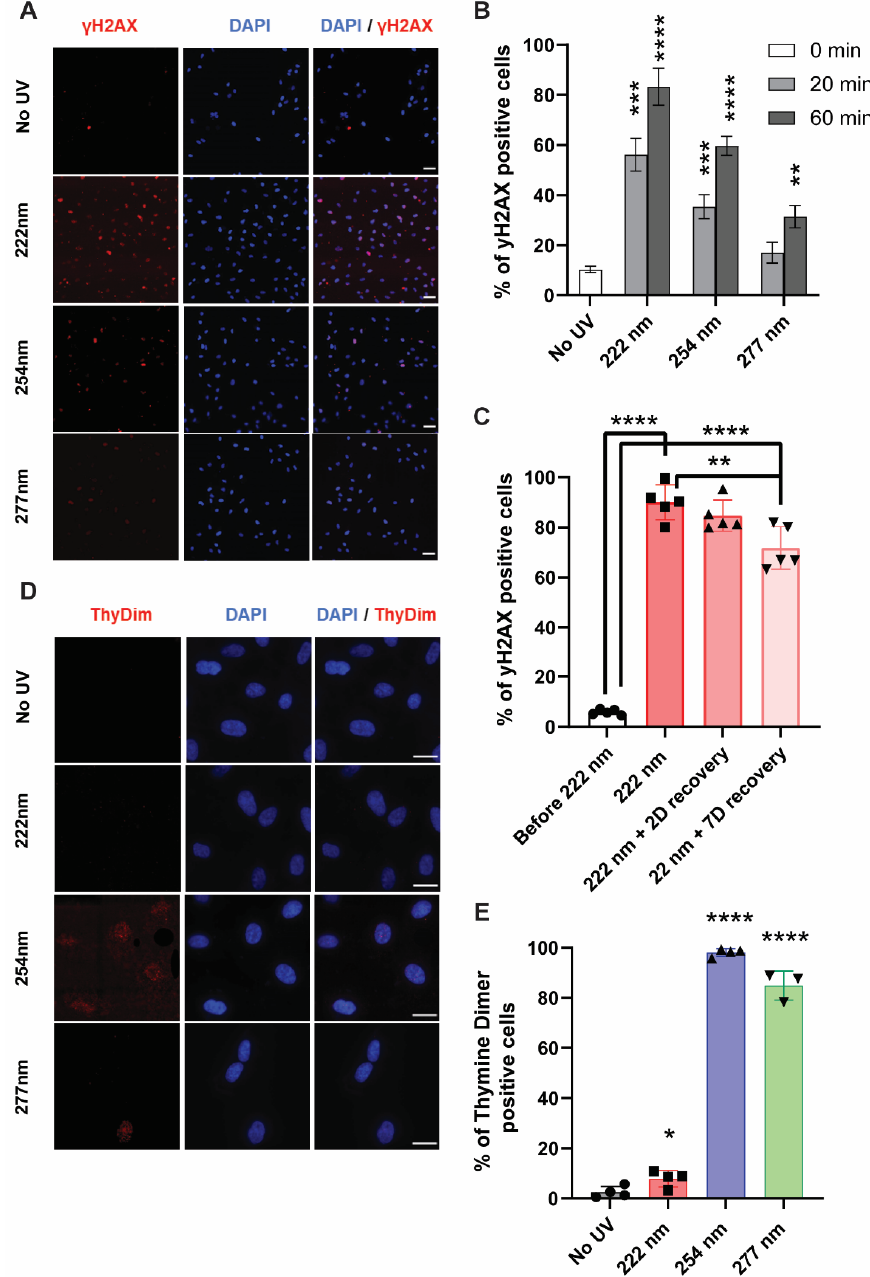
Figure 3. DNA-associated damage or associated repair mechanisms were observed in 222-nanometer-lit cells. ( A ) γ H2AX staining in ARPE19 cells upon 60 min of respective UVC irradiation. Scale bars = 50 µ m. ( B ) Quantification of the extent of γ H2AX activation in the ARPE19 cells upon 0, 20, and 60 min of UVC illumination. Values are reported as mean +/ − SD from n = 3 experiments. ( C ) Quantification of the extent of γ H2AX activation in the ARPE19 cells exposed to 60 min of 222-nanometer far-UVC illumination and then recovered 0, 2, and 7 days after the far-UVC treatment. Values are reported as mean +/ − SD from n = 5 experiments. ( D ) Thymine dimer staining in ARPE19 cells upon 60 min of respective UVC irradiation. Scale bars = 20 µ m. ( E ) Quantification of the extent of thymine dimer formation in the ARPE19 cells after 60 min of UVC illumination. Values are reported as mean +/ − SD from n = 3–4 experiments. Where applicable, Student’s t -test is performed and significance is represented as * p < 0.05, ** p < 0.01, *** p < 0.001, and **** p <